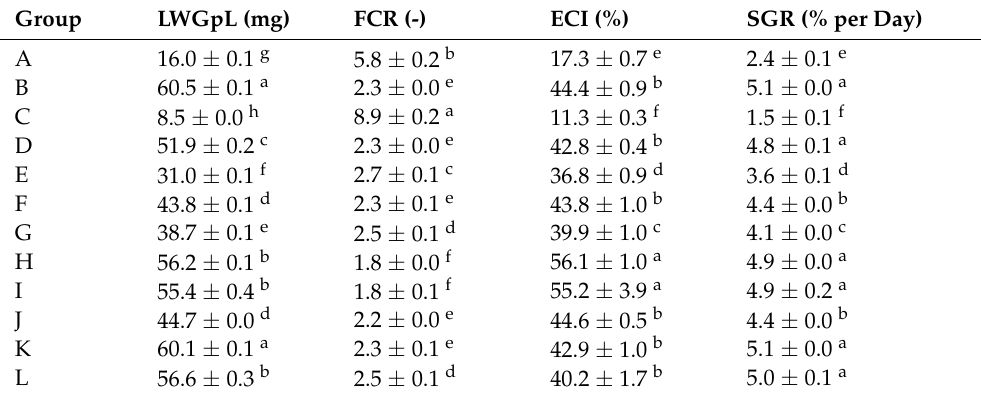
Table 2. Average larval weight gain per larvae, feed conversion ratio (FCR), feed conversion efficiency (ECI) and specific growth rate (SGR) of Tenebrio molitor larvae. Values are given as mean ± standard deviation, n =